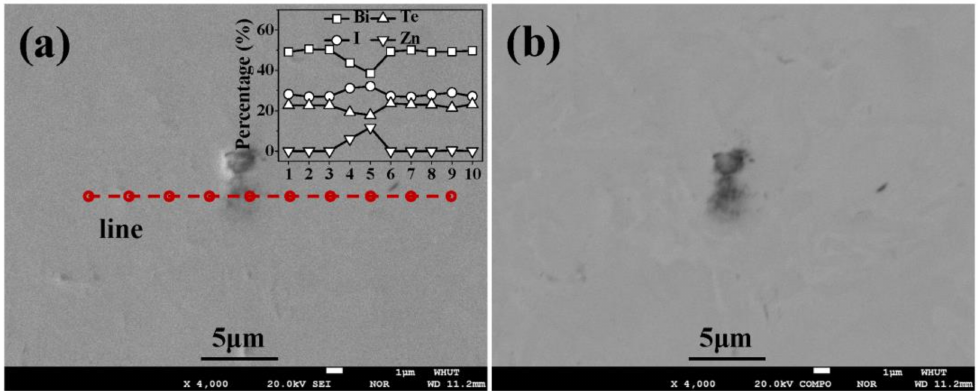
Figure 6. ( a ) Secondary electron image and ( b ) backscattered electron image of a large Zn-rich area on Zn 0.015 Bi 2 TeI sample. The elemental distribution along the line marked in ( a ) is also presented.